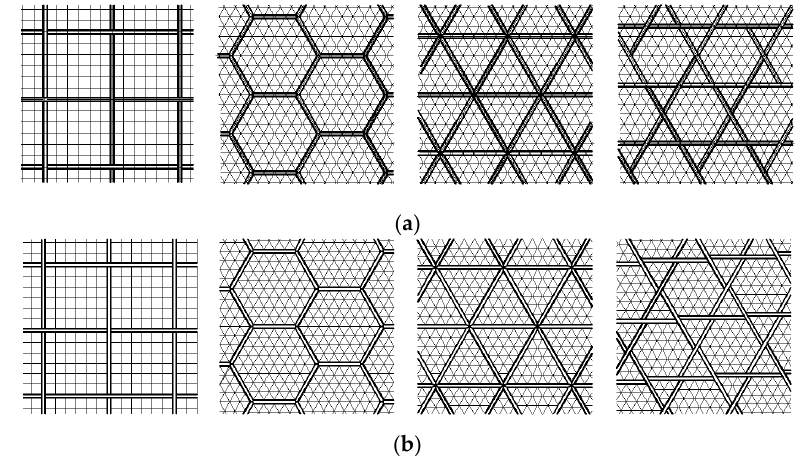
Figure 18. Linking the vaults with a beam grids, based on coincidence of the modular planes with: ( a ) the center planes of the beams, or ( b ) planes containing the sides of the beams.